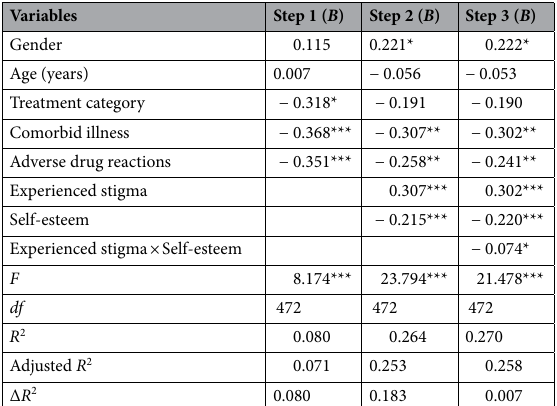
Table 3. Results of hierarchical multiple regression analysis on anxiety. df degrees of freedom. * P < 0.05. ** P < 0.01. *** P < 0.001 (two-tailed).